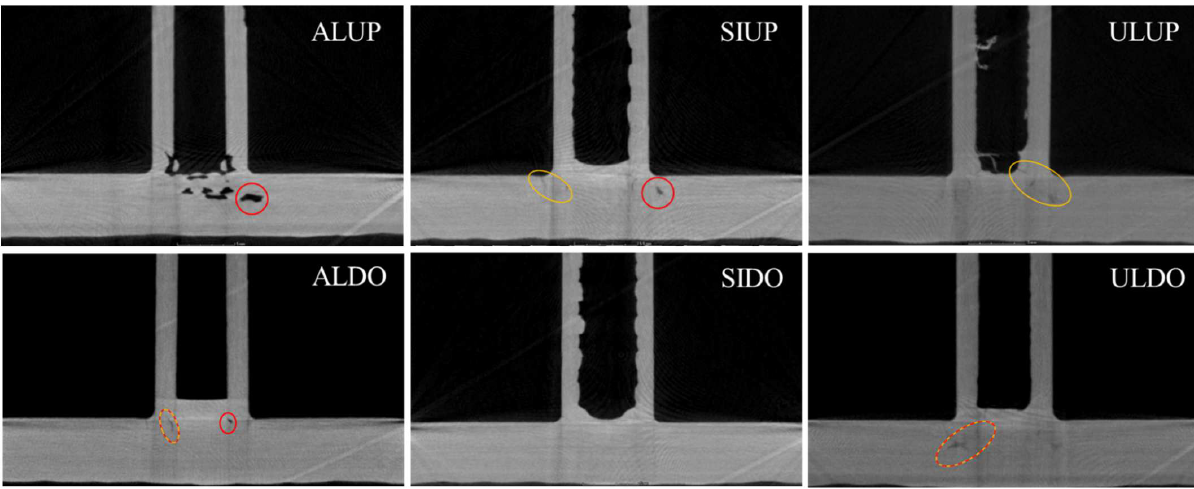
Figure 7. CT cross-sections of pi-NCF parts. Yellow circles show indications of cracking, red high- lights larger areas of porosity, a combination of red/yellow indicates both.